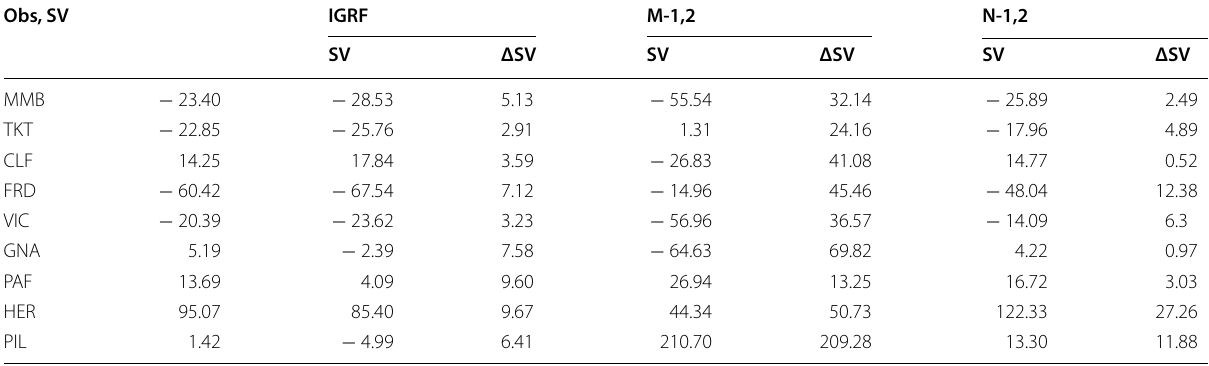
Table 4 Comparison of SV (Z) predictions based on IGRF, M-1,2 and N-1,2 models with observatory data. All values are given in nT/year Obs,